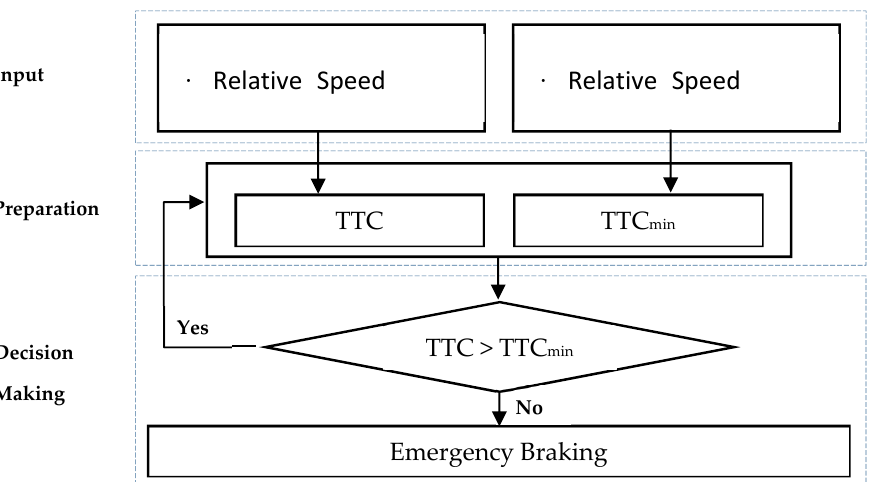
Figure 3. AEBS algorithm.